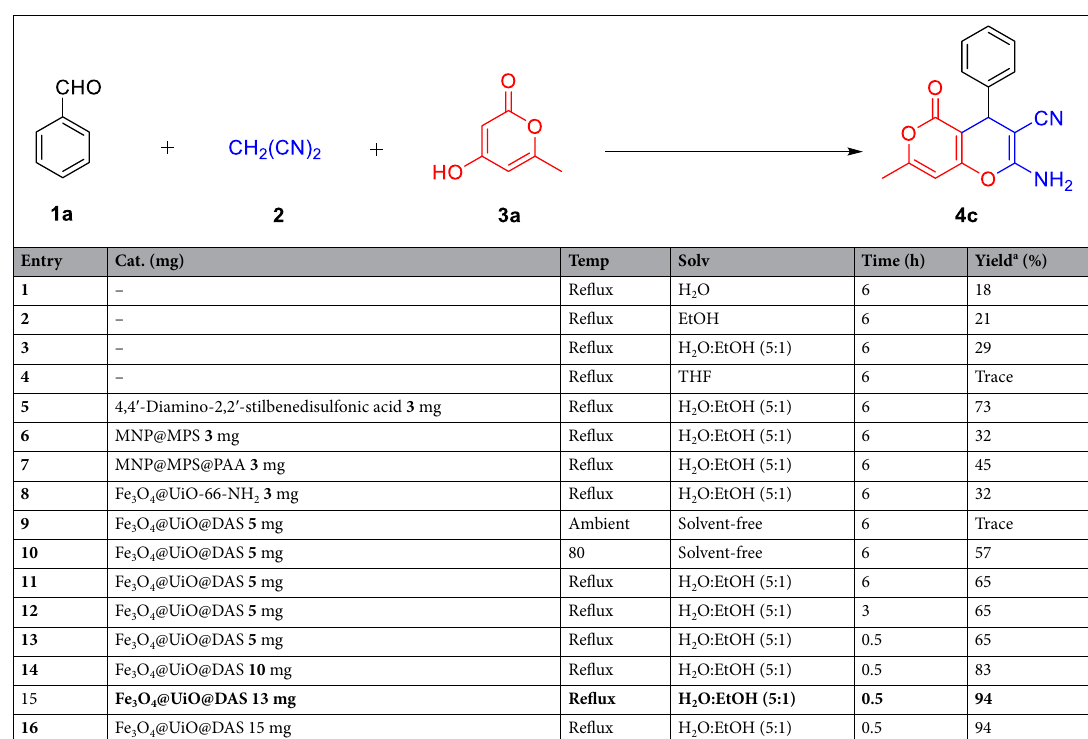
Table 2. Optimization of the reaction condition for the synthesis of 2-amino-3-cyano-4 H -chromene catalyzed by